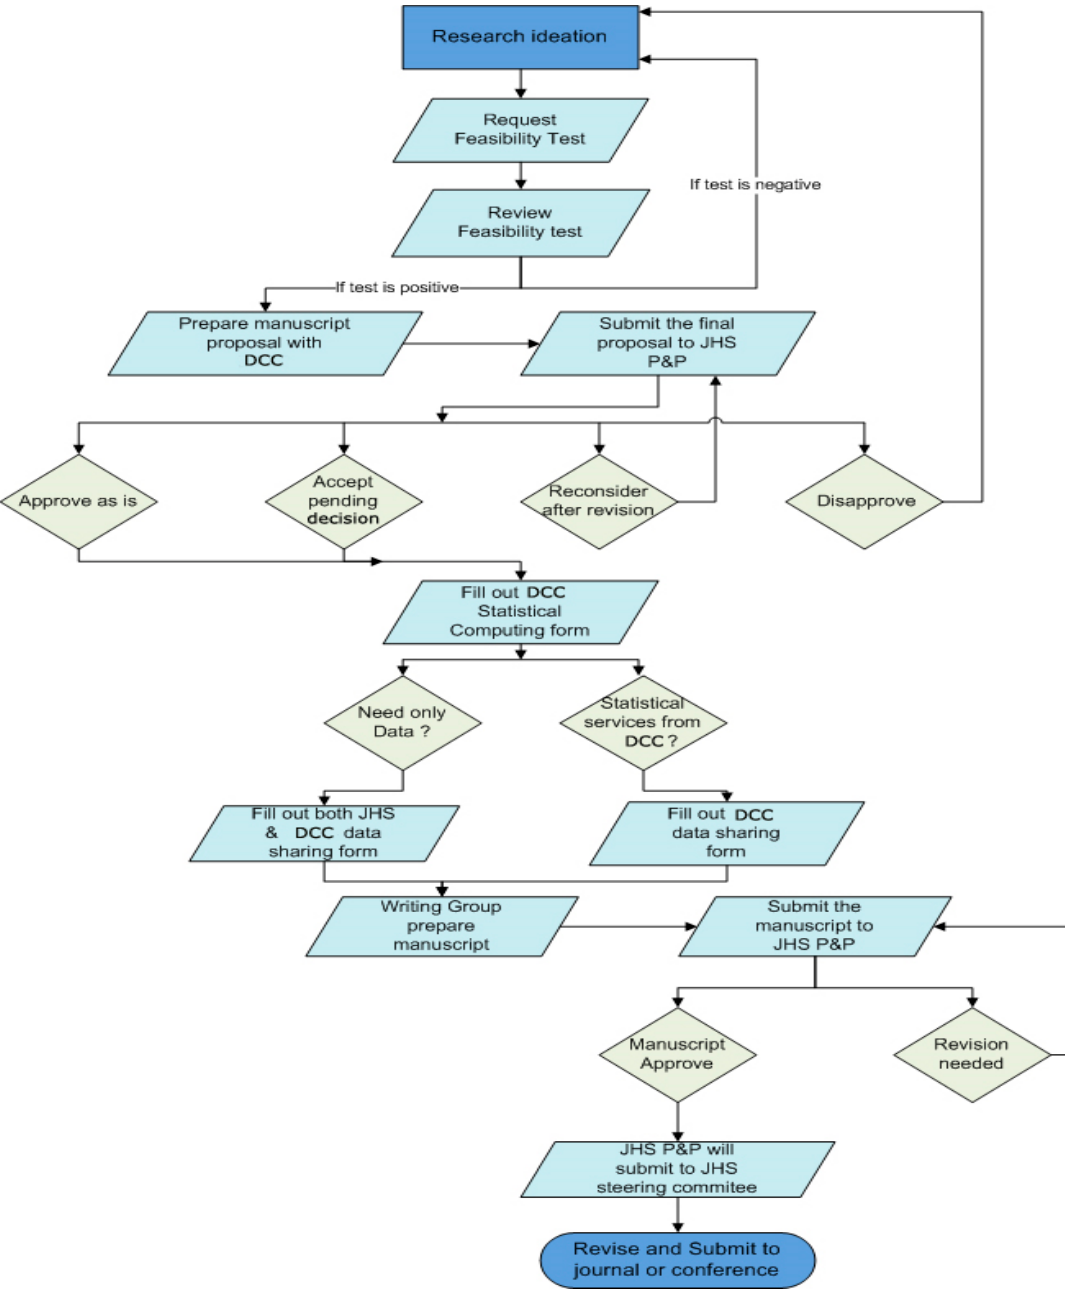
Figure 1. Process to develop research.